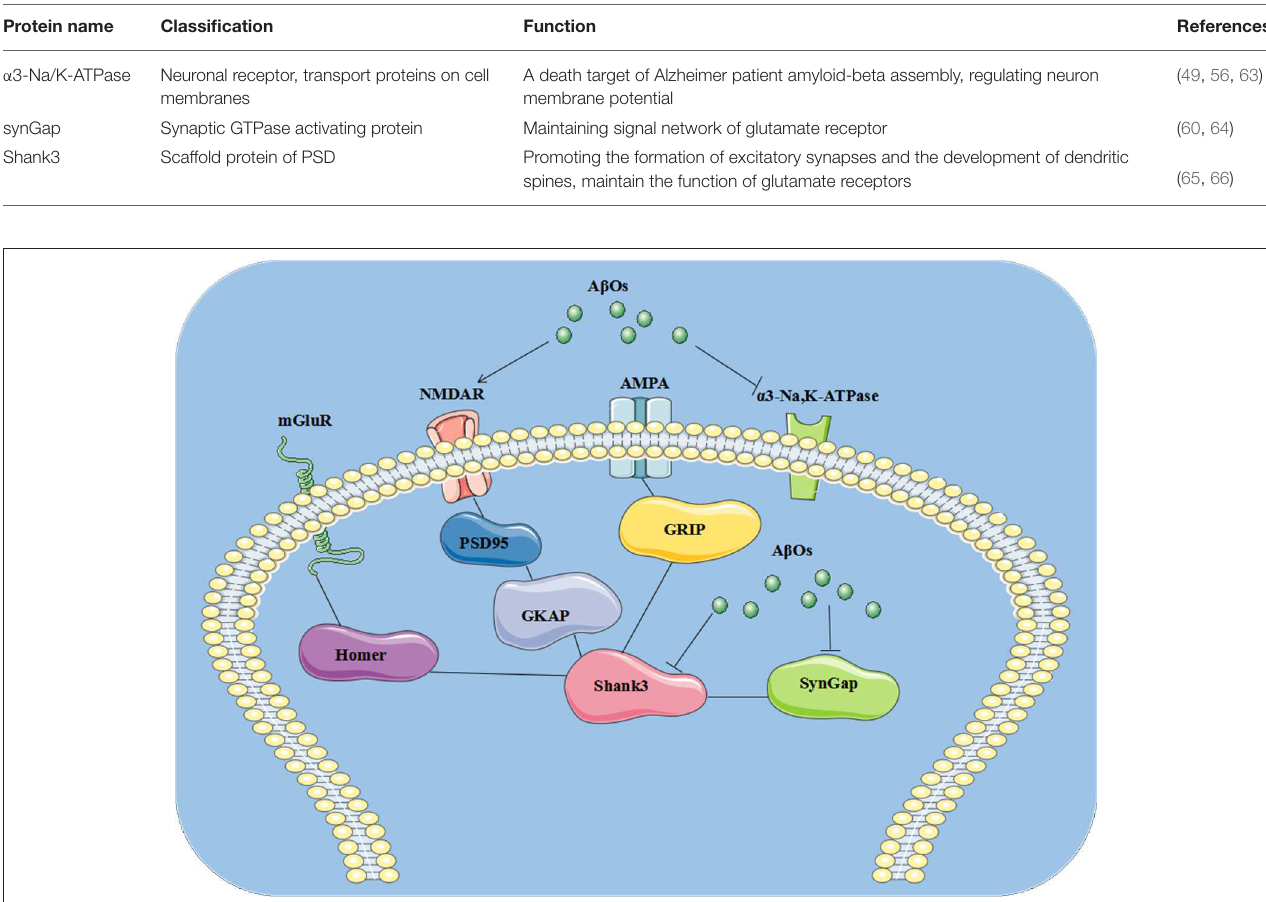
FIGURE 9 | The pathological changes at synapse induced by A β Os. A β Os binding Na/K-ATPases could develop in early stages of AD brain, leading to synaptic dysfunction, while later stages could hypothetically result from disrupted synapse structure involving the PSD proteins synGap and Shank3.